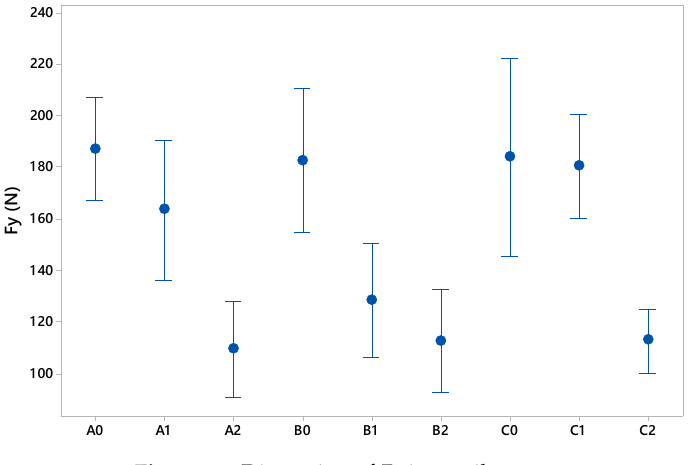
Figure 12. Dispersion of F y in tensile tests.